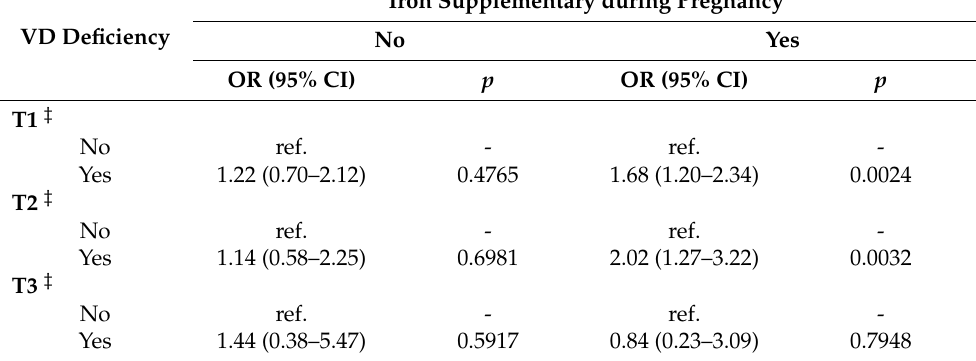
Table 5. The association * between VD deficiency in different trimesters and anemia during pregnancy after the corresponding 25(OH)D measurement, stratified by whether iron was supplementary during pregnancy or